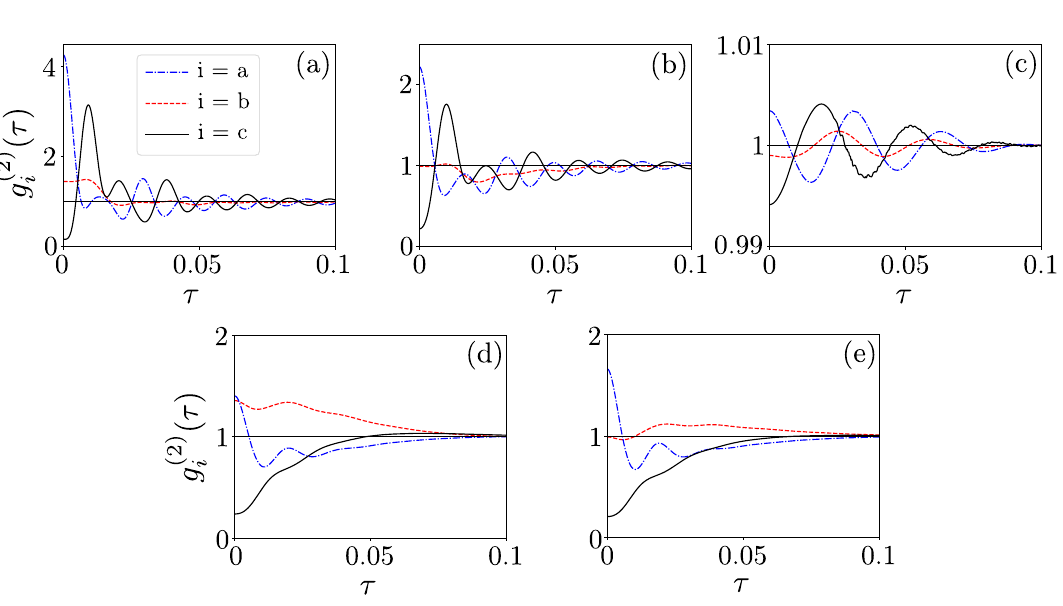
Figure 4. Delay-time second-order correlation functions: ( a ) g ( 2 ) the phononic mode, and ( c ) g c (τ) for the hybrid mode versus the coupling strength g and the delay time τ . We consider here the SMR-driven system with parameters specified in Eq. (28), which enable us to observe the single-photon resonances in the mode c . For clarity, all the values of the correlation functions at 2.